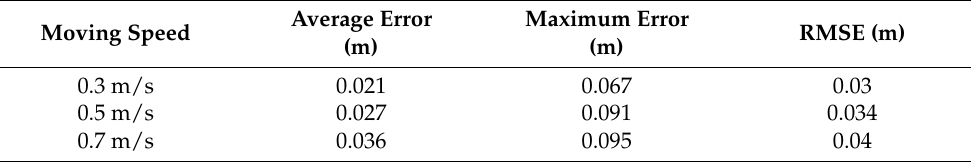
Figure 7. Lateral error at different moving speeds. Table 4. Statistics and analysis of lateral error at different moving